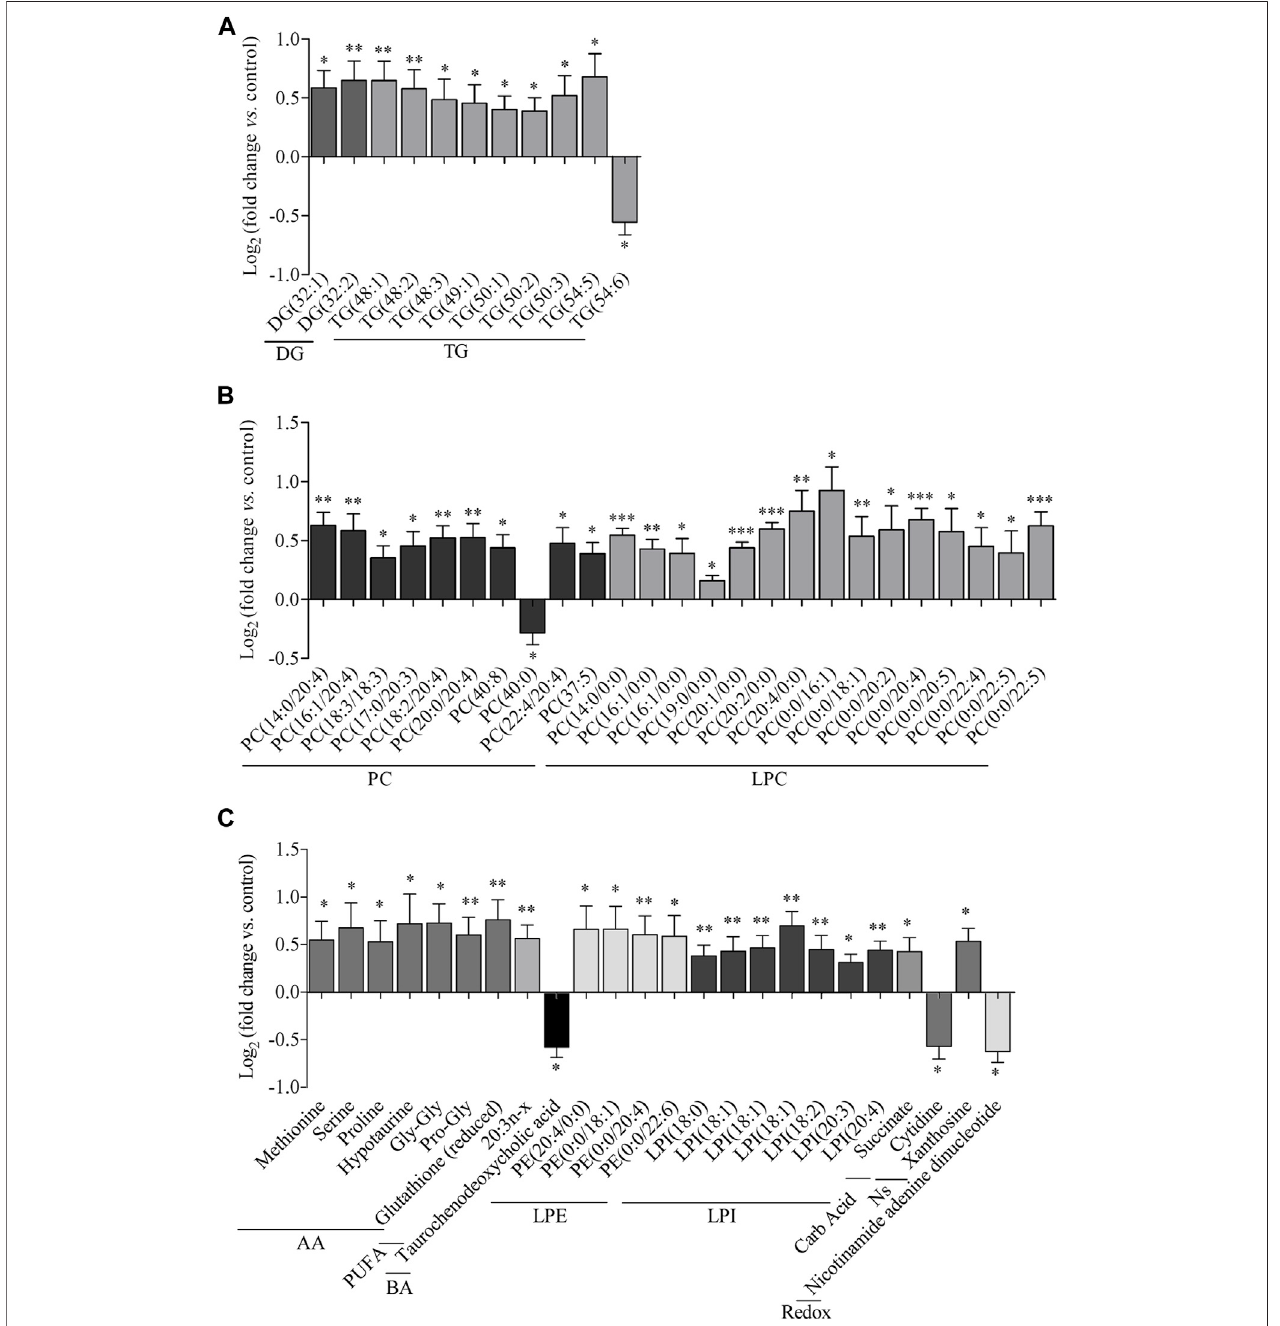
FIGURE2| Metabolic features altered in the liver by empagli fl ozin treatment. Metabolomic analysis of liver tissue from rats treated with empagli fl ozin vs control. Relative log 2 (fold-change) of glycerides (A) , phosphatidylcholines and lysophosphatidylcholines (B) , amino acids (C) , polyunsaturated fatty acids (C) , bile acids (C) , lysophosphatidylethanolamines (C) , lysophosphatidylinositols (C) , carboxylic acids (C) and redox molecules (C) . DG, diacylglycerides; TG, triacylglycerides; PC, phosphatidylcholines; LPC, lysophosphatidylcholines; AA, amino acids; PUFA, polyunsaturated fatty acids; BA, bile acids; LPE, lysophosphatidylethanolamines; LPI, lysophosphatidylinositols; Carb Acid., carboxylic acids; Redox, molecules participating in redox homeostasis. * p < 0.05, ** p < 0.01, *** p < 0.001.